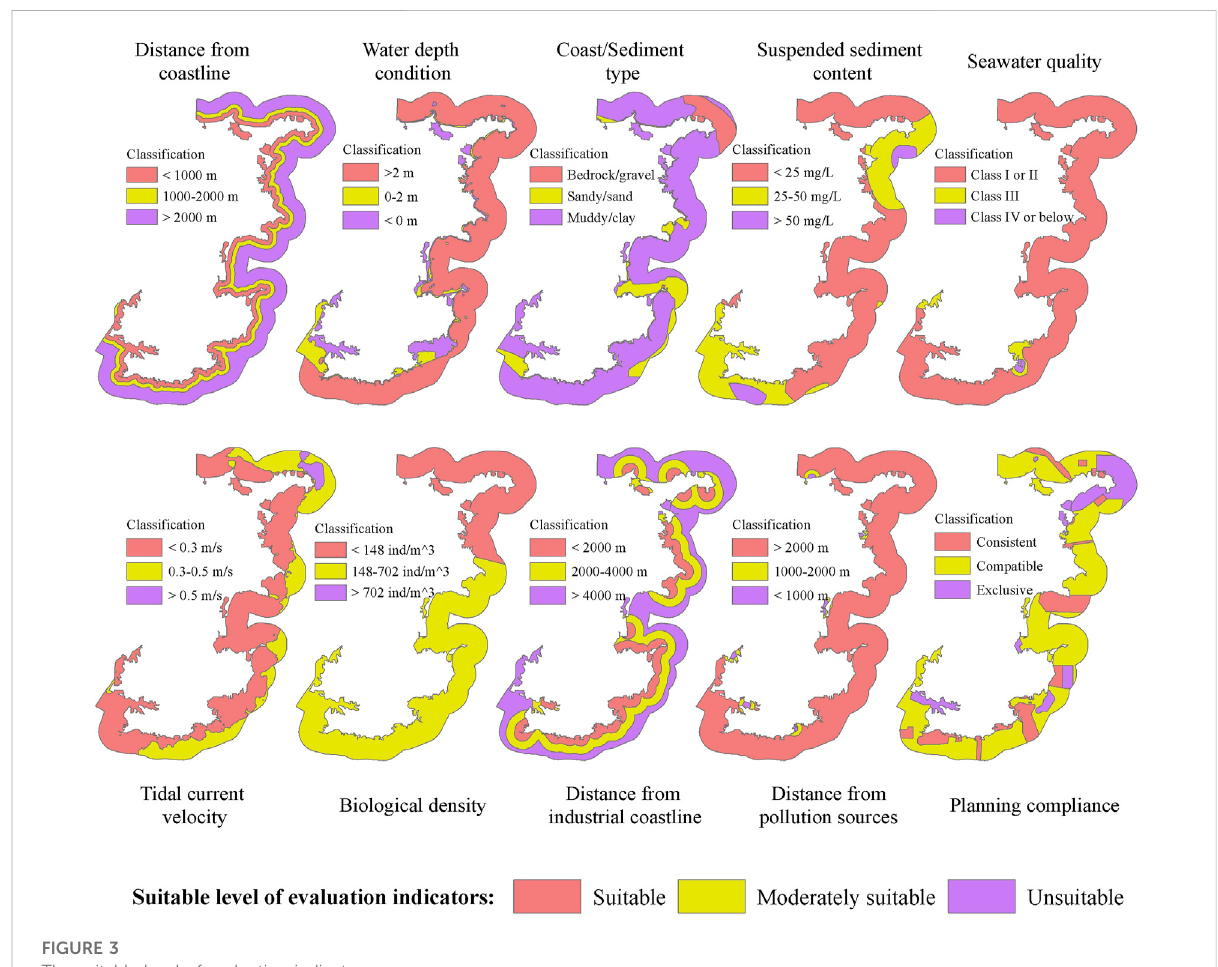
FIGURE 3 The suitable level of evaluation